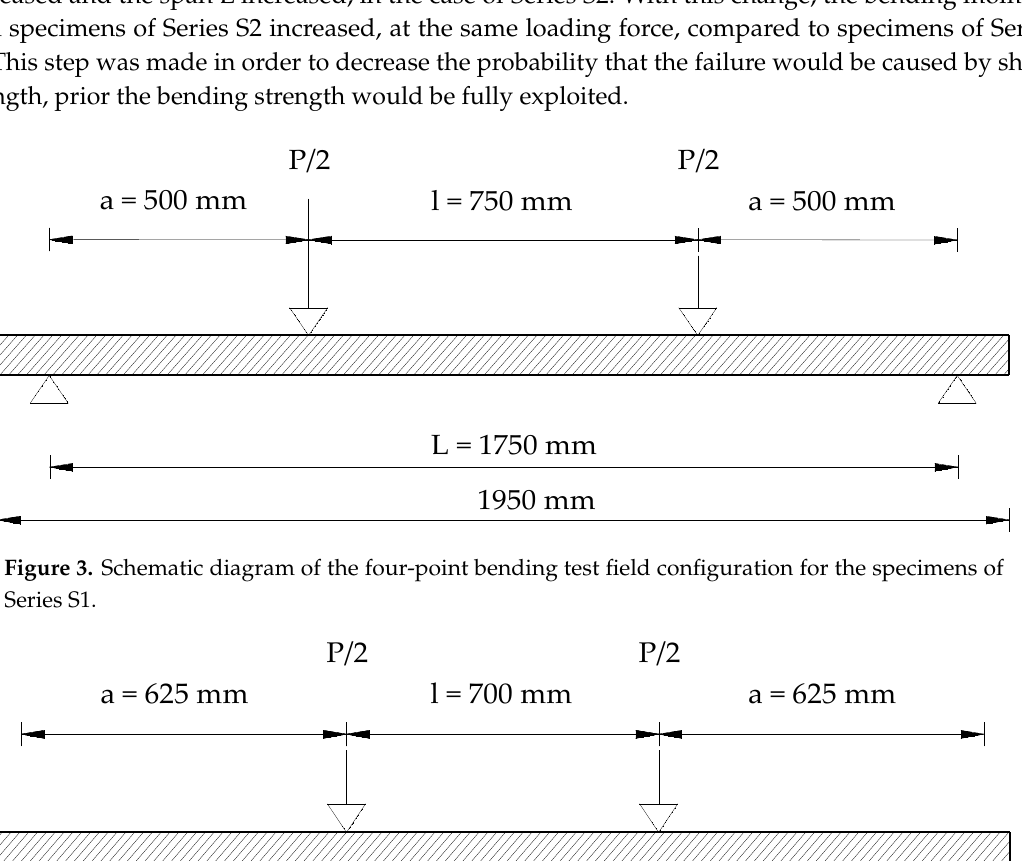
Figure 4. Schematic diagram of the four-point bending test field configuration for the specimens of Series